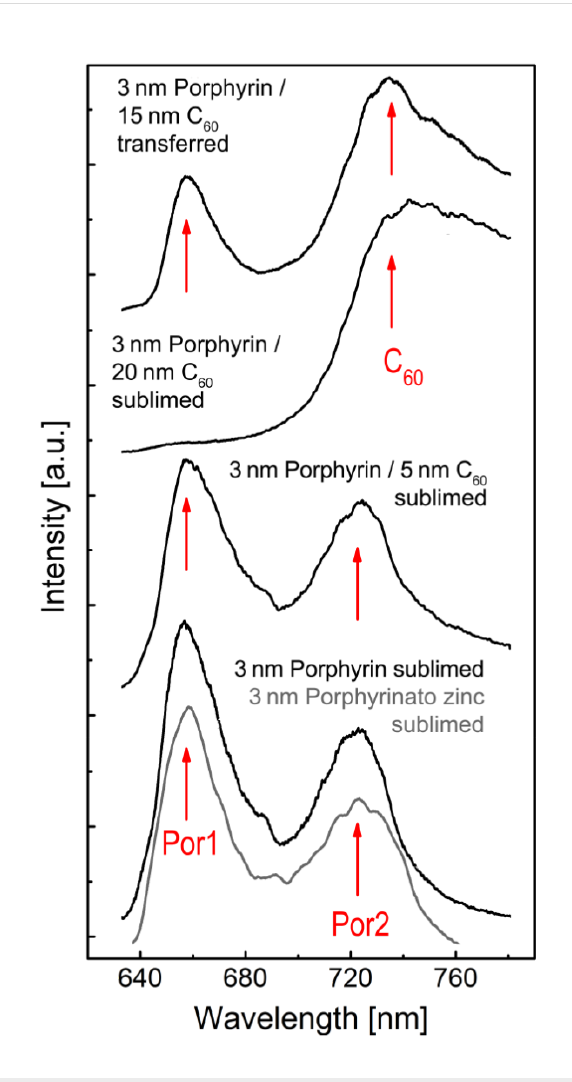
Figure 3: Normalised fluorescence emission spectra (excitation wave- length = 532 nm) of sublimed and transferred porphyrin on SiO 2 /Si substrates with C 60 cover layers of varying thickness; the character- istic double peak at 656 ± 1 nm and 722 ± 1 nm (655 ± 1 nm and 720 ± 1 nm for Zn-TBPP) corresponds to the porphyrin Q band region [31-33], the broadened emission band at about 740 nm corresponds to the excited singlet and triplet states of C 60